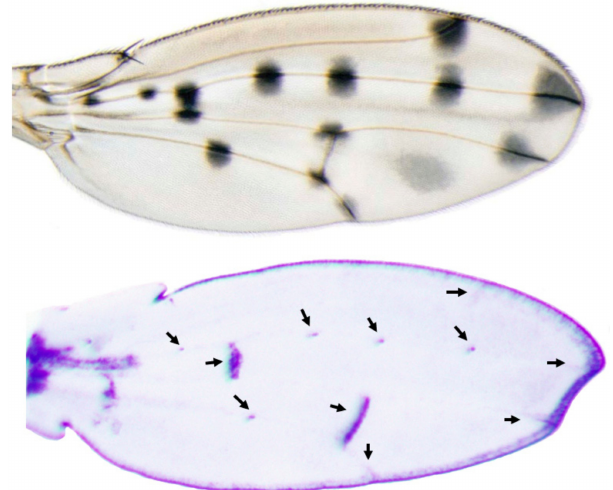
Figure 5. The wingless mRNA expression foreshadows the adult spot pattern on the wing of D. guttifera . This image has been previously published in Werner et al. [6].